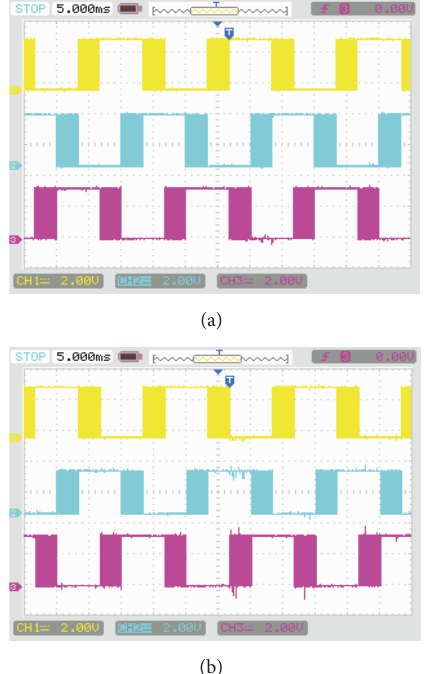
Figure 10: Upper and Lower PWM of three-phase inverter under 120-BCM.